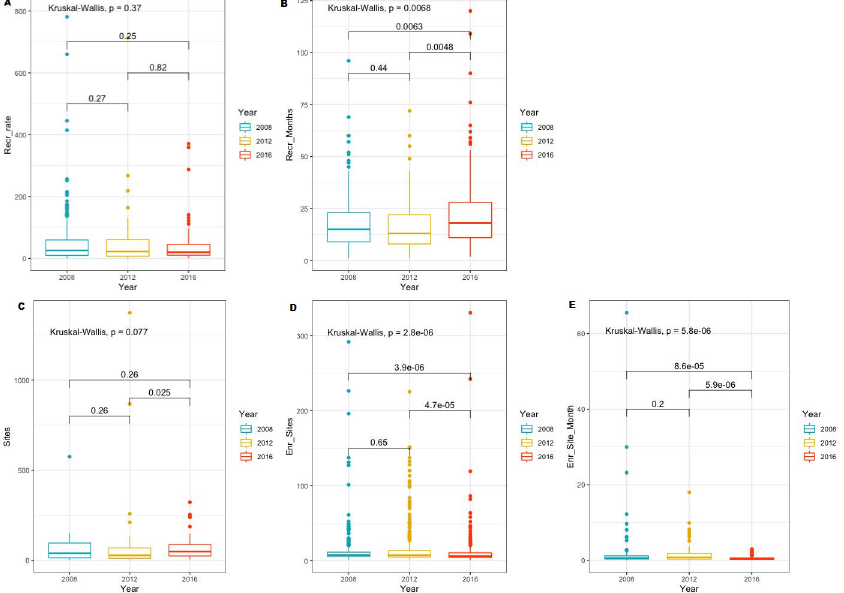
Fig 3. Comparison of key recruitment metrics across the three time periods from 2008–2019 (A: Comparison of recruitment rate (mean, IQR), B: Comparison of recruitment duration in months (mean, IQR), C: Comparison of the number of sites (mean, IQR), D: Comparison of the number of participants enrolled per site (mean, IQR), E: Comparison of the number of participants enrolled per site per month (mean, IQR)).